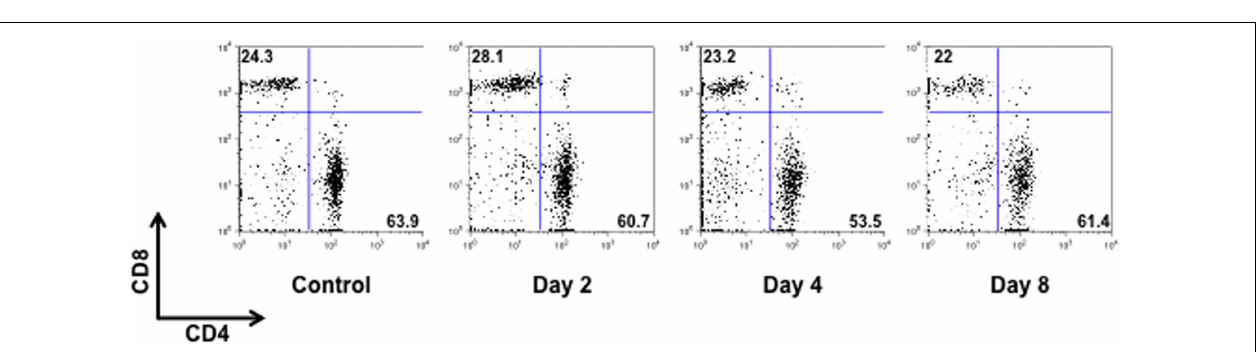
FIGUREA1 | Behavior of MOG 35–55 -immunized mice in the open field test .The graphs show the percentage of total number of squares crossed (A) , number of central squares entries (B) , and latency to rearing (C) of control or MOG 35–55 -immunized mice compared to their baseline levels